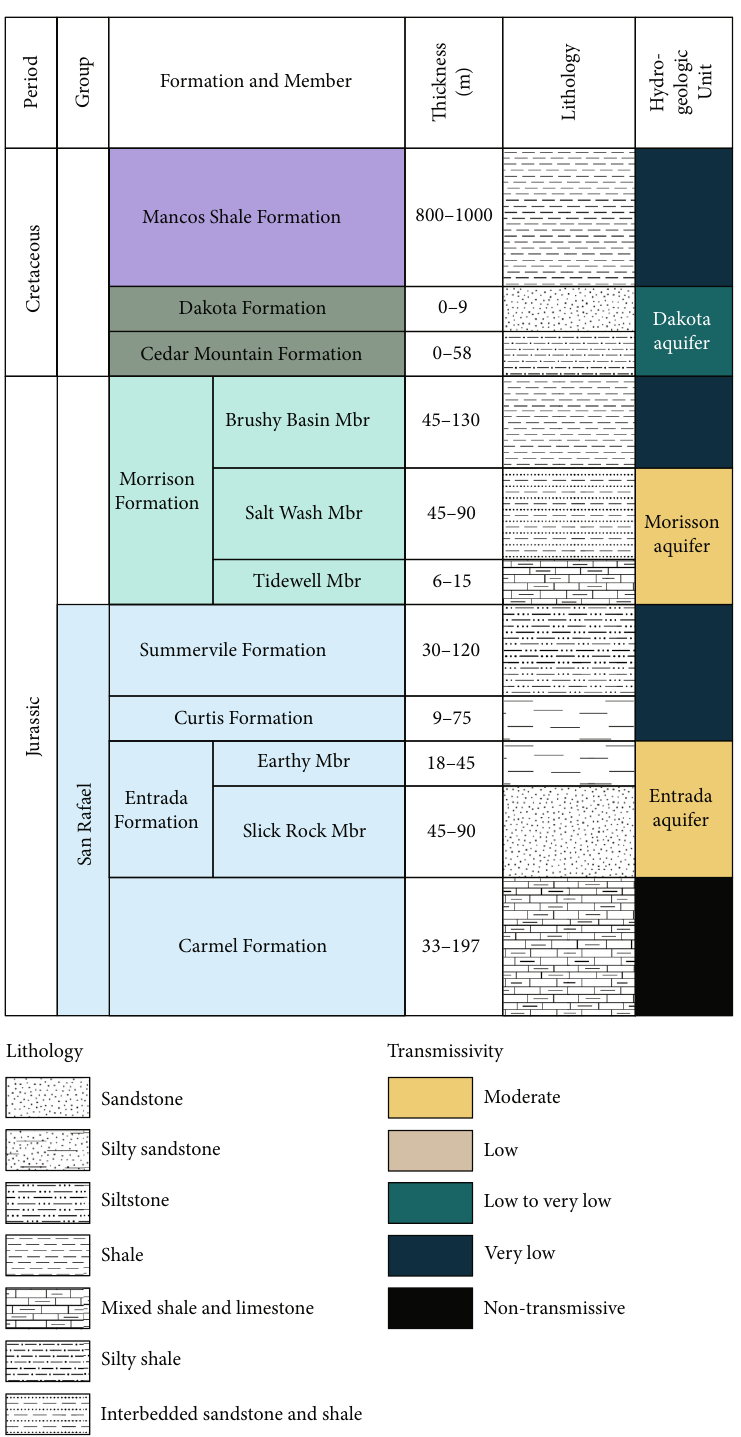
Figure 2: Stratigraphic section of the Cretaceous and Jurassic units of this study, including the range of thickness, lithologies, and hydrogeologic units. The colour of the stratigraphic units corresponds to the units of Figure 1, and the units in bold font are exposed at the study site (see Figure 3). The original stratigraphic section was modi fi ed from Doelling et al. [15]. Hydrogeologic classi fi cation was modi fi ed from Kampman et al.